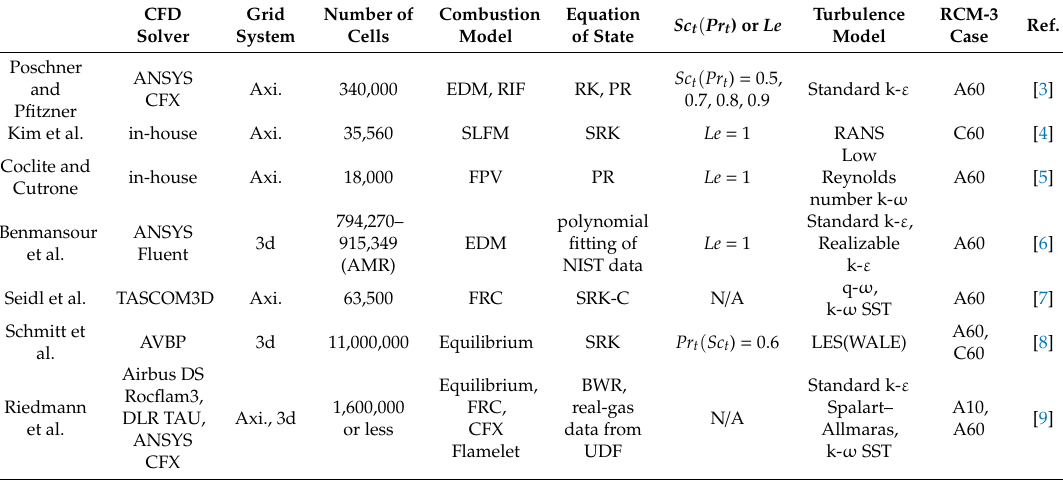
Table 1. Comparison of numerical studies for Rocket Combustor Modelling (RCM)-3 test case.